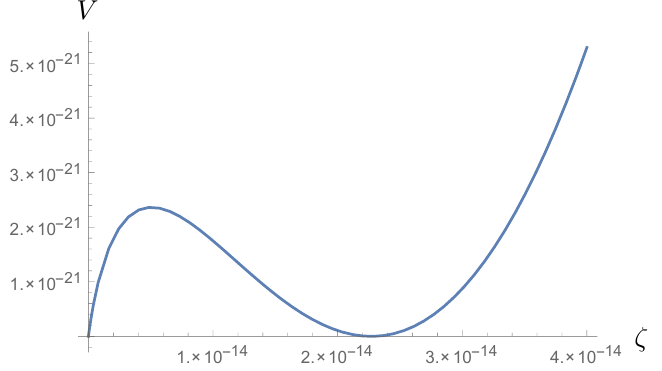
Figure 3 . Potential V ( (cid:16) ) for (cid:27) 0 = 0 and the choice of parameters: M = 1, K = 1, g s = 1 = 5 and (cid:28) =